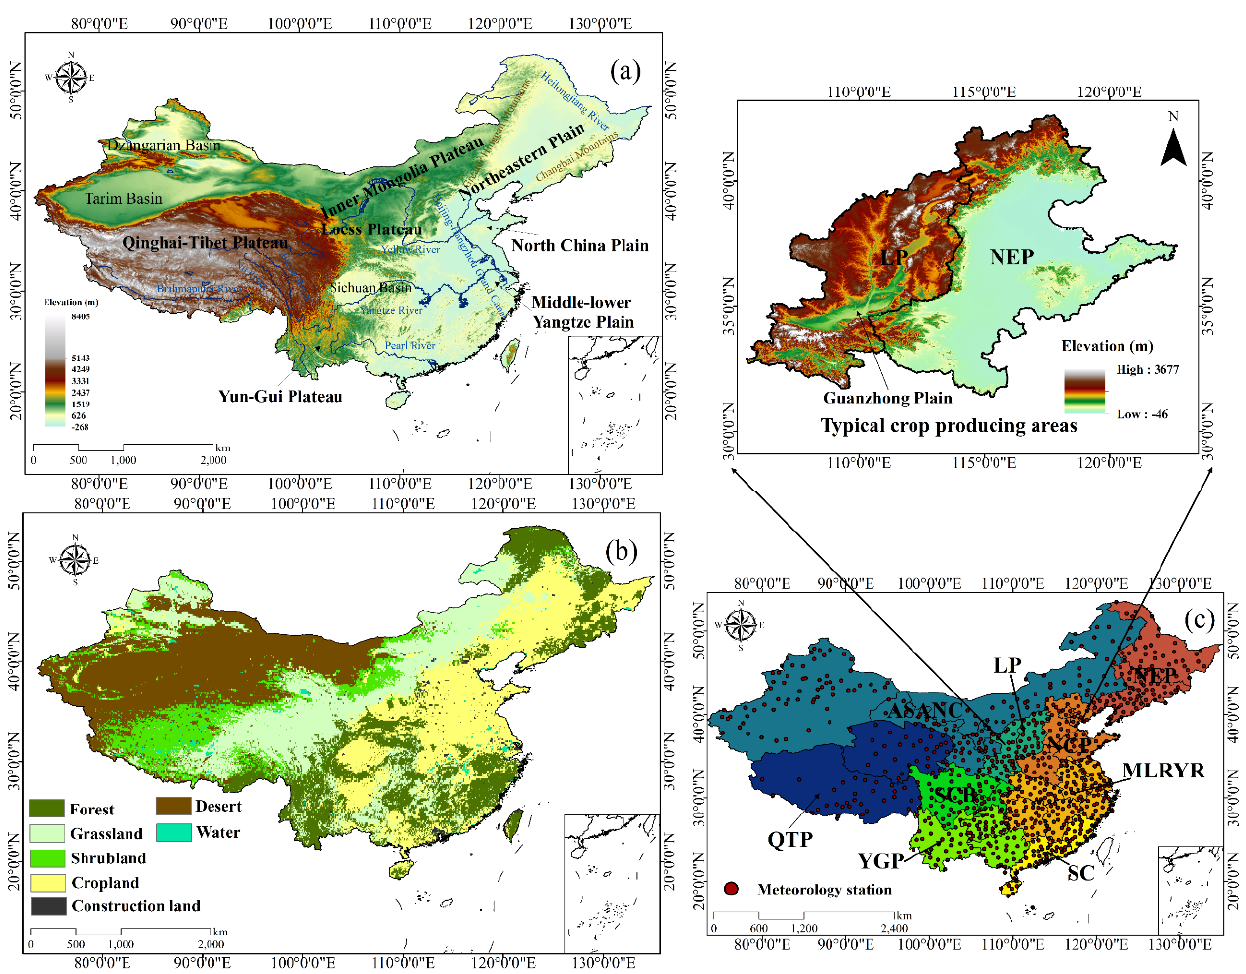
Figure 1. Topographic and geographic zones in China ( a ), ecological vegetation types in China ( b ), and the nine major crop-producing areas in China and typical crop-producing areas ( c ).